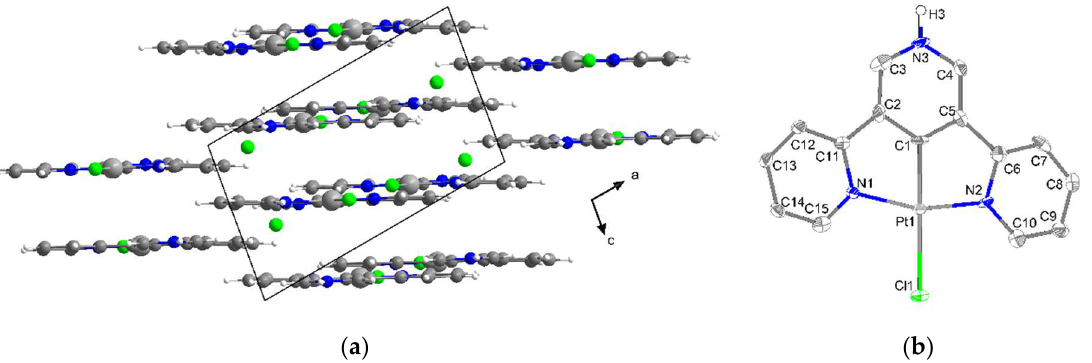
Figure 2. View of the crystal structure of [Pt(2,3′:5′,2″-terpyH)Cl] . Cl ( Pt-H2-ClCl ) along the b -axis ( a ) and ORTEP plot of the molecular structure with displacement ellipsoids at 50% probability; H atoms other than the N–H and the Cl − counterion were omitted for clarity ( b ).